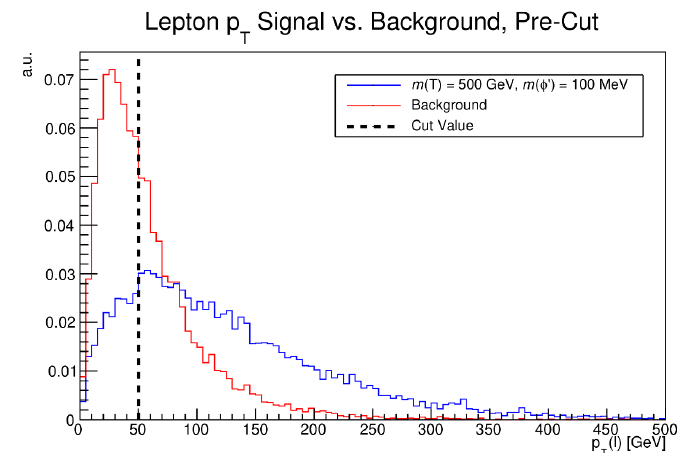
Figure 8 . Distribution of p T ( ‘ ) for signal (blue) and background (red) samples. Signal events were generated assuming m ( T ) = 500 GeV , m ( φ 0 ) = 100 MeV . The y -axis normalization is arbitrary. The vertical black dashed line denotes the location of the selection cut.